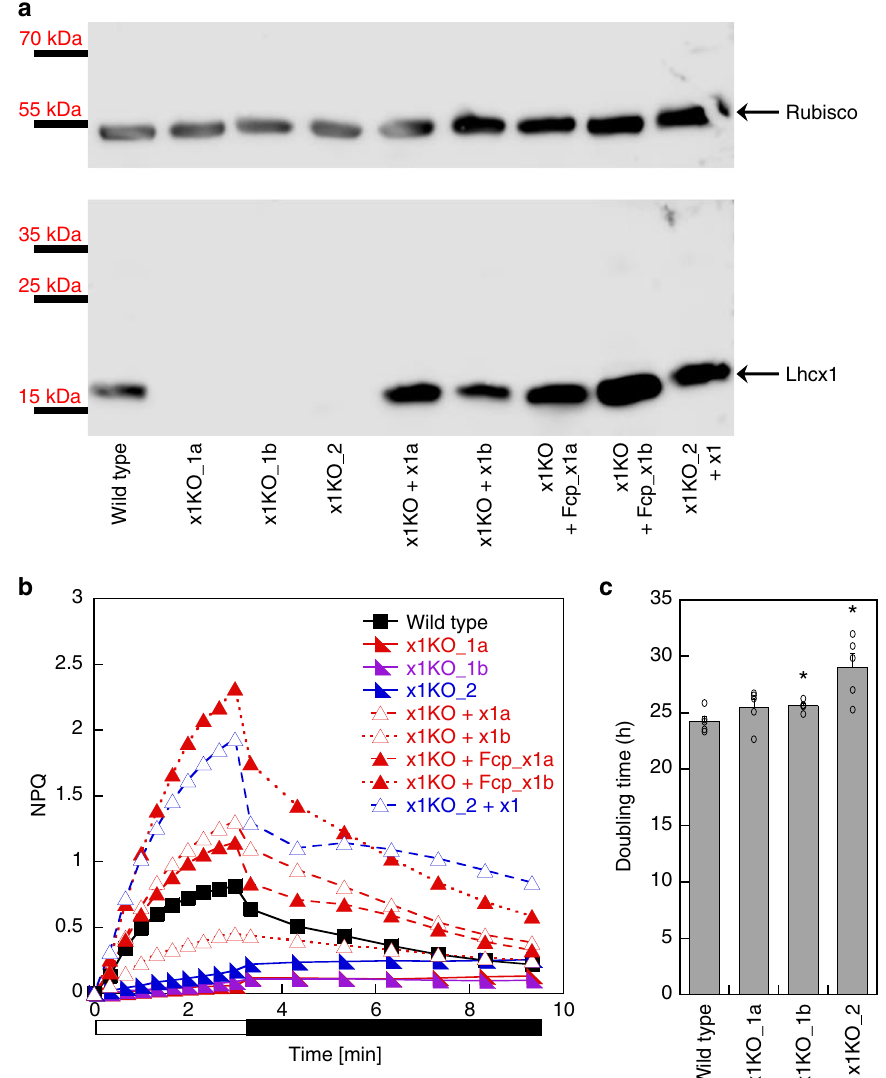
Fig. 1 qE capacity in P. tricornutum Lhcx1 mutants. a Western blot of low light grown strains, from left to right: wild type, three x1KO lines (x1KO_1a,1b and 2), two complemented lines of the x1KO_1a with the Lhcx1 gene cloned between the Lhcx1 promoter and terminator (x1KO + x1a,b) and between the FcpA promoter (x1KO + Fcp_x1a,b), respectively, and one complemented line of the x1KO_2 line (x1KO_2 + x1). After blotting, the blot was cut and the upper part was incubated with a Rubisco antibody, whereas the lower part was incubated with the Lhcx antibody. Protein mass marker bands are indicated on the left. b NPQ development during 3 min of actinic high light (white bar) followed by 6 min of recovery in darkness (black bar). Representative traces are depicted. c Mean doubling time in the exponential growth phase in the wild type and three x1KO lines during low light growth. SE is given. Statistically signi fi cant differences between the x1KO lines and the wild-type are indicated by a * (unpaired t test, eight degrees of freedom, p < 0.05, n = 5 biological replicates). Source data are provided as a Source Data fi